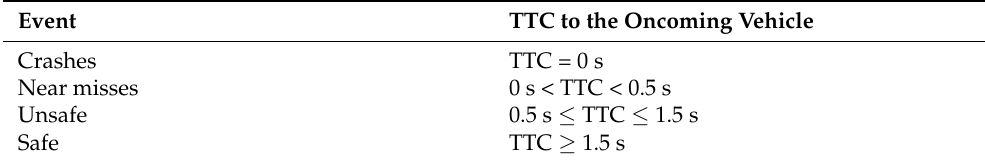
Table 3. Collision events related to the TTC